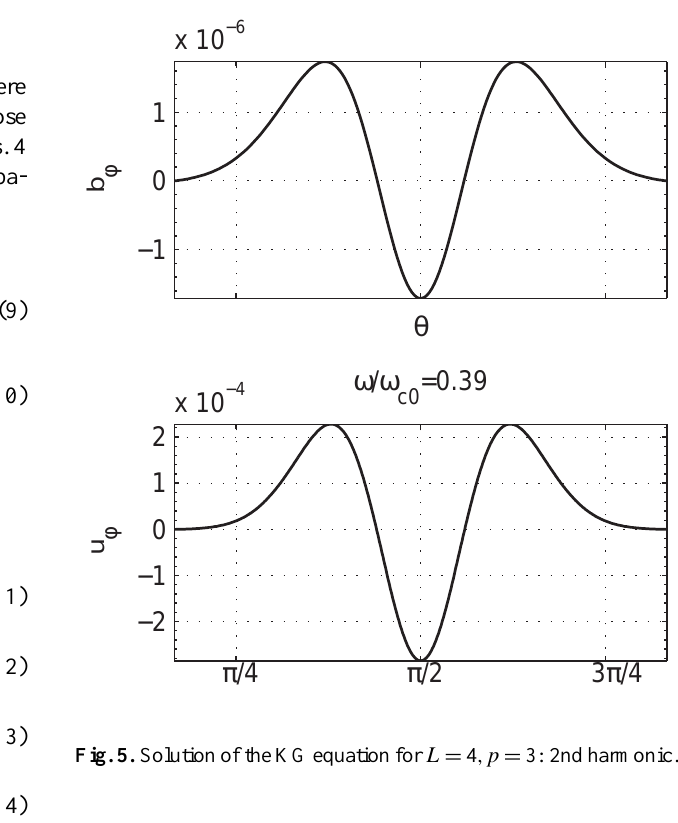
Fig. 3. Solution of the KG equation for L = 4 ,p = 3 : the fundamental mode. Both u φ and b φ are of arbitrary units.